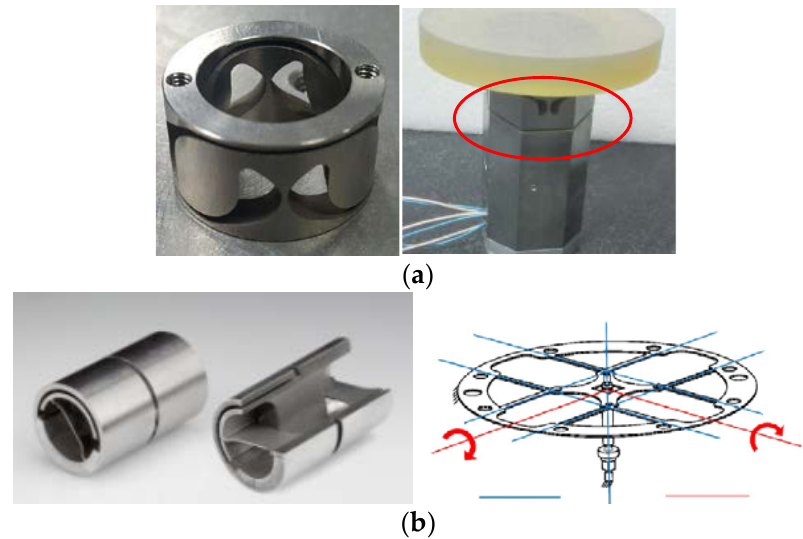
Figure 10. Flexural hinge; ( a ) Notch type; ( b ) Tape-spring type.